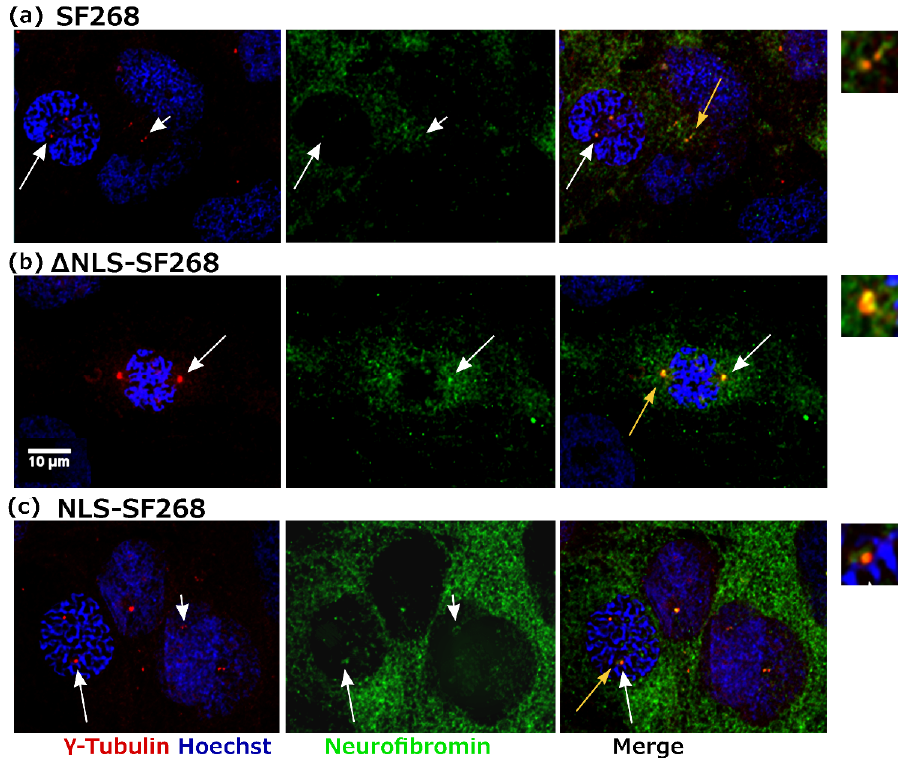
Figure 5. Differential neurofibromin isoform colocalization with γ-tubulin on mitotic centrosomes. ( a ) SF268, ( b ), ΔNLS and ( c ) NLS synchronized late S-G2 cells were fixed with PFA and immunostained with γ -tubulin (red) and neurofibromin (green); chromatin was stained with Hoechst (blue).